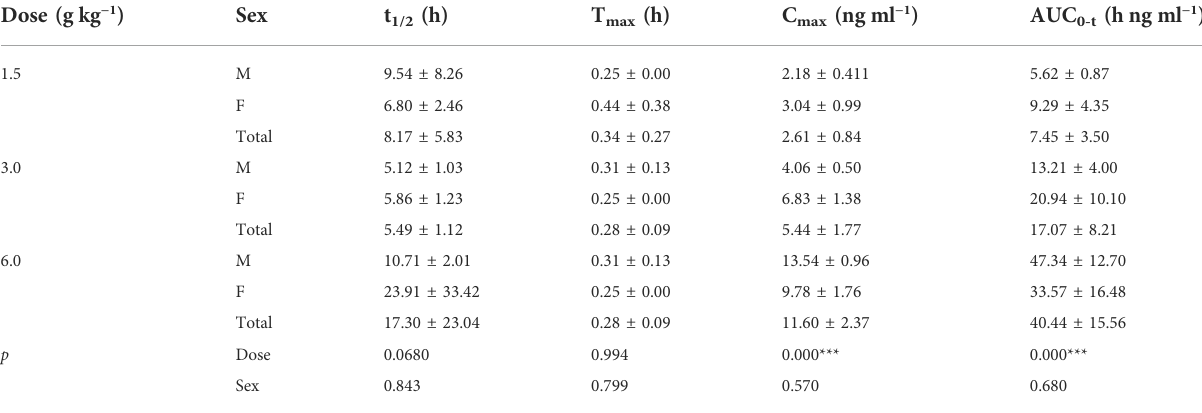
TABLE 4 Pharmacokinetic parameters of isoliquiritigenin after different doses of TYZB in rats (D1). Dose (g kg − 1